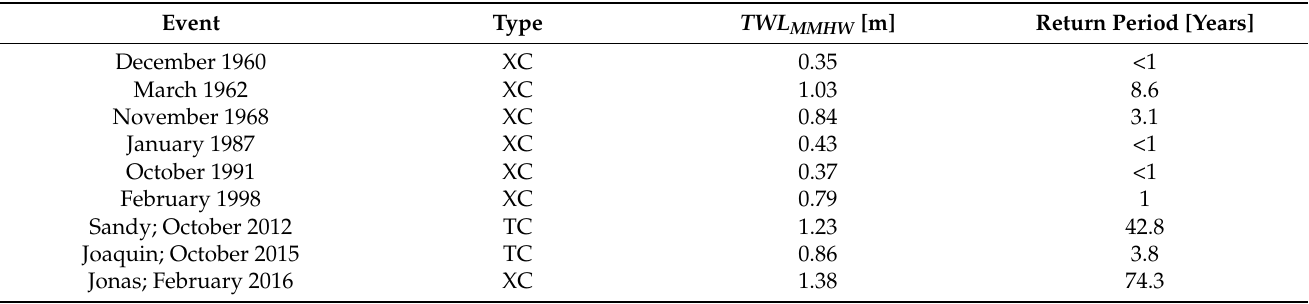
Table A2. The values used in Figure 7 are shown as red diamonds, with the calculated return periods shown as filled black circles. This is not an exhaustive list of events that occurred near the study site; rather, it is a selection of event types and values for comparison